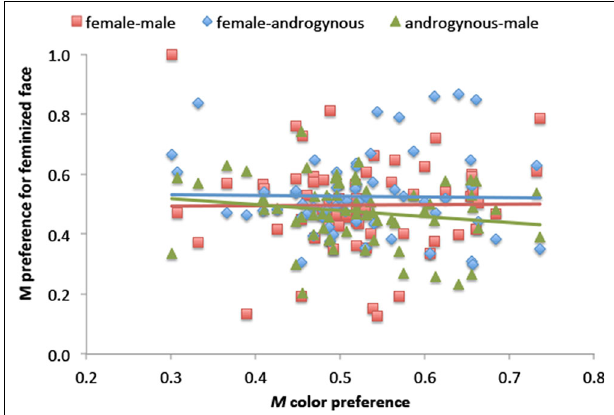
FIGURE 3 | Correlations between M color preference (i.e., preference for darker colors) and preference for feminized faces in comparisons of female vs. male (red), female vs. androgynous (blue), and androgynous vs. male (green). Corresponding colored trend lines are superimposed.